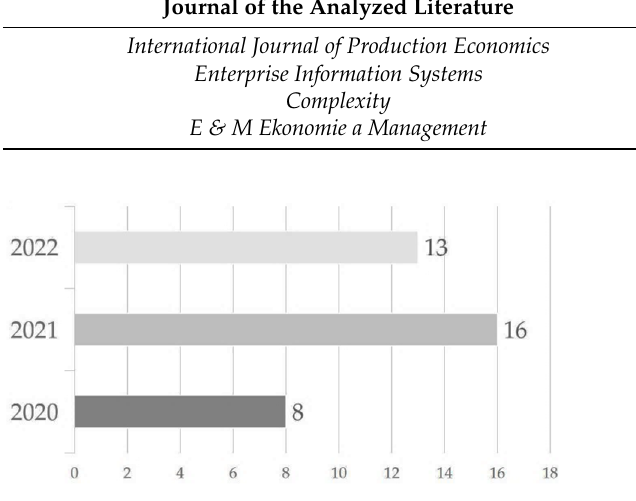
Figure 2. Distribution of publications from 2020 to 2021.